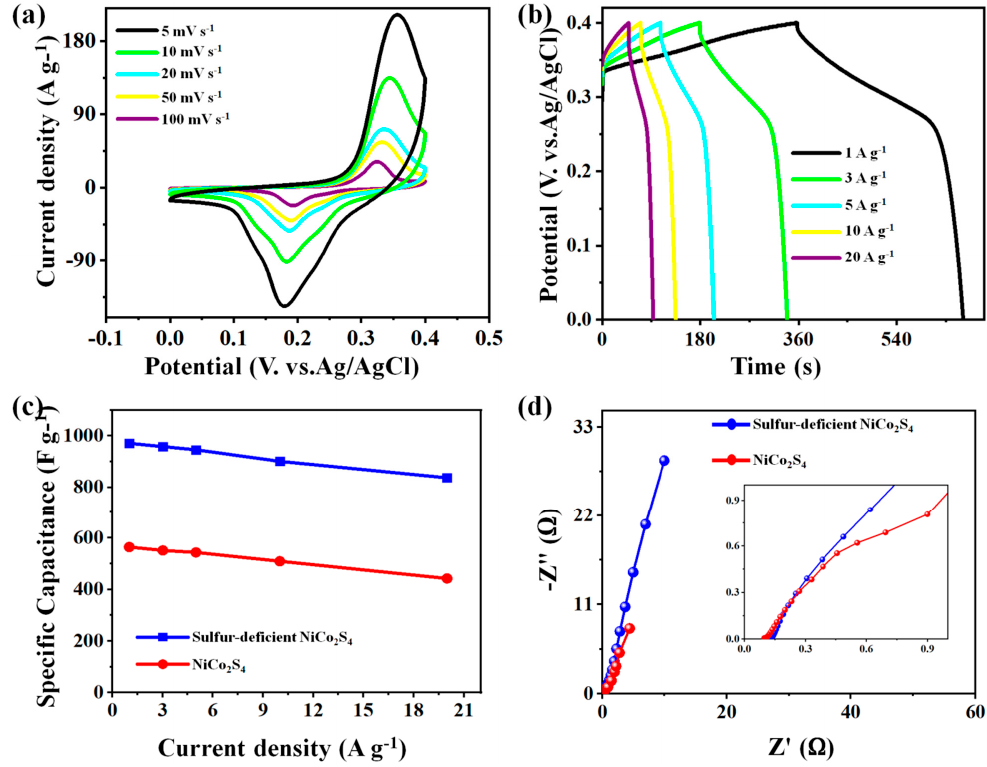
Figure 6. ( a ) CV curves and ( b ) GCD curves of the sulfur-deficient NiCo 2 S 4 nanosheets composite electrode; ( c ) specific capacitances and ( d ) EIS curves of the pure NiCo 2 S 4 nanoparticles electrode, and sulfur-deficient NiCo 2 S 4 nanosheet composite electrodes.